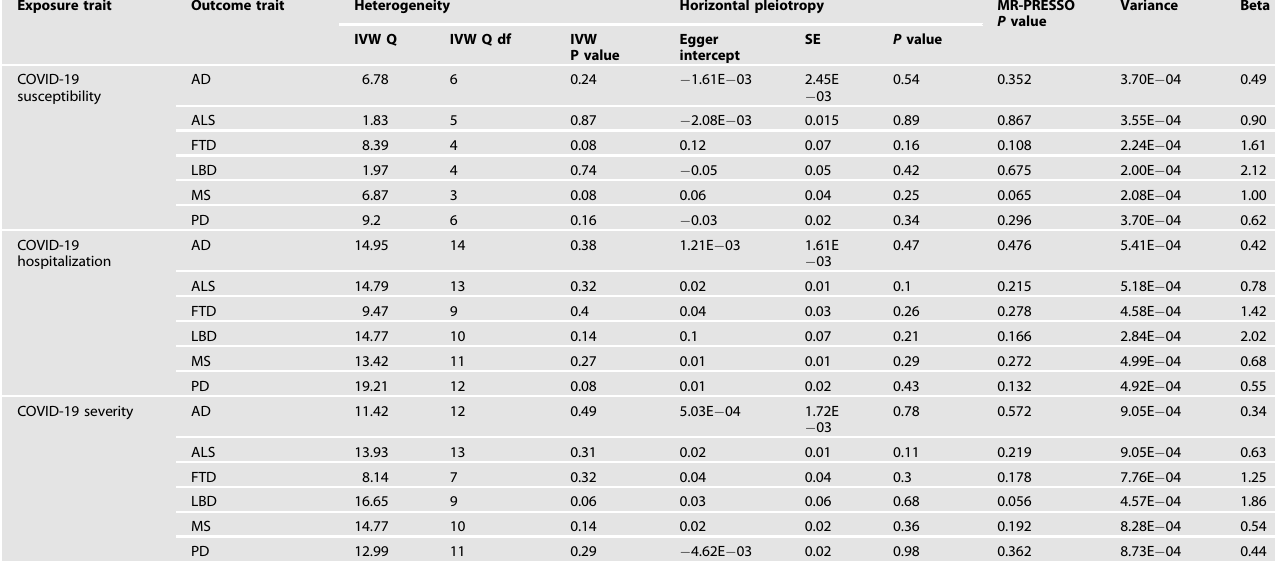
Table 1. Heterogeneity and horizontal pleiotropy analyses between COVID-19 and neurodegenerative disorders. Exposure